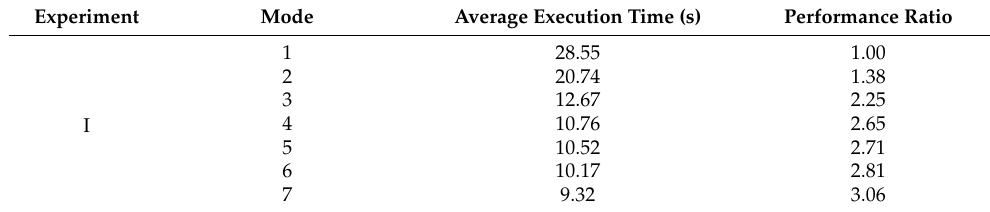
Table 9. Comparison of the performance ratio of each mode in the experiments.